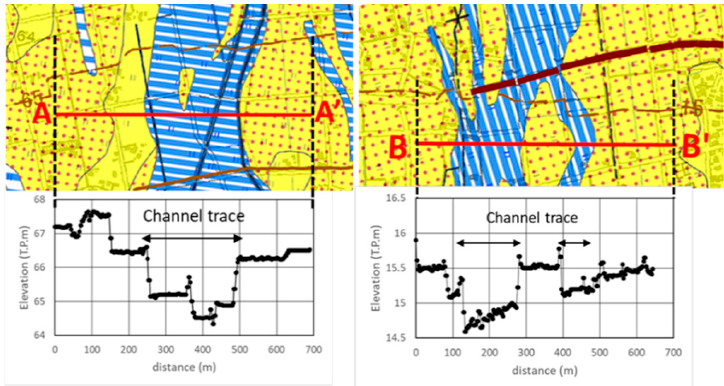
Figure 7. Examples of ground depression of old river channel trace. Upper: landform classification map. Blue hatched area is the old river channel trace. Lower: cross-section profile along the red line in the upper figure.